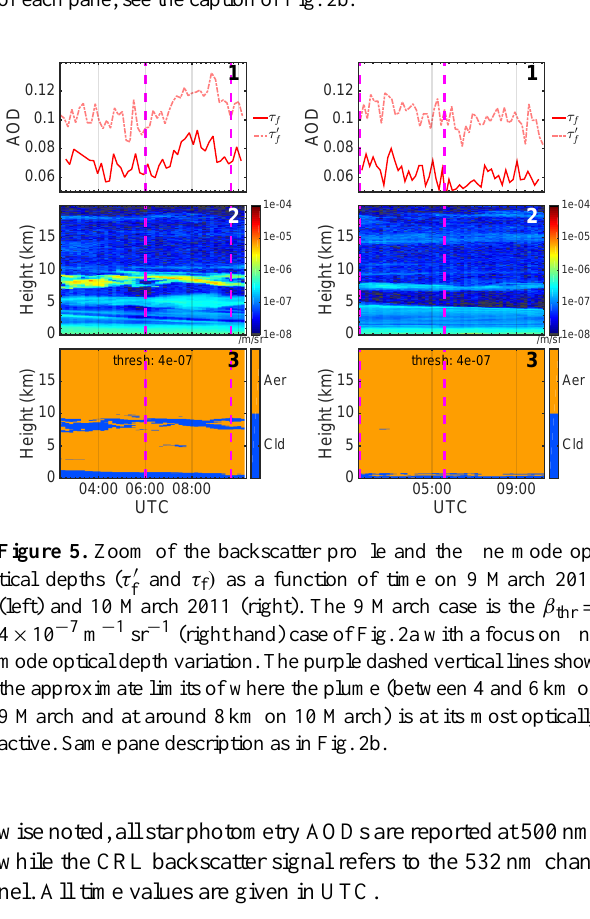
Figure 4. Eureka aerosol event, 9–10 March 2011. For a description of each pane, see the caption of Fig. 2b.